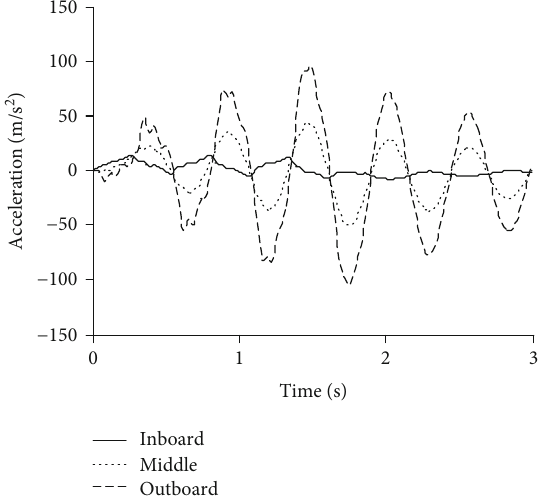
Figure 12: Transient response of acceleration at typical sections of wing under repeated waves.